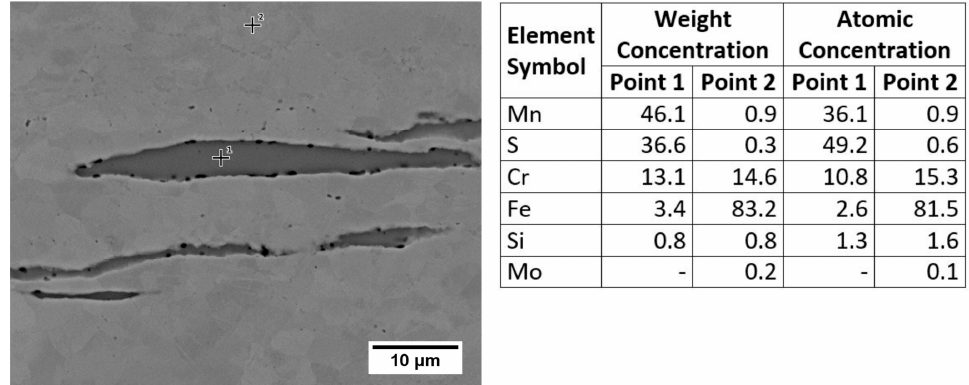
Figure 4. SEM microstructure and EDS point analysis of AISI 430F (X12CrMoS17) base metal (polished).